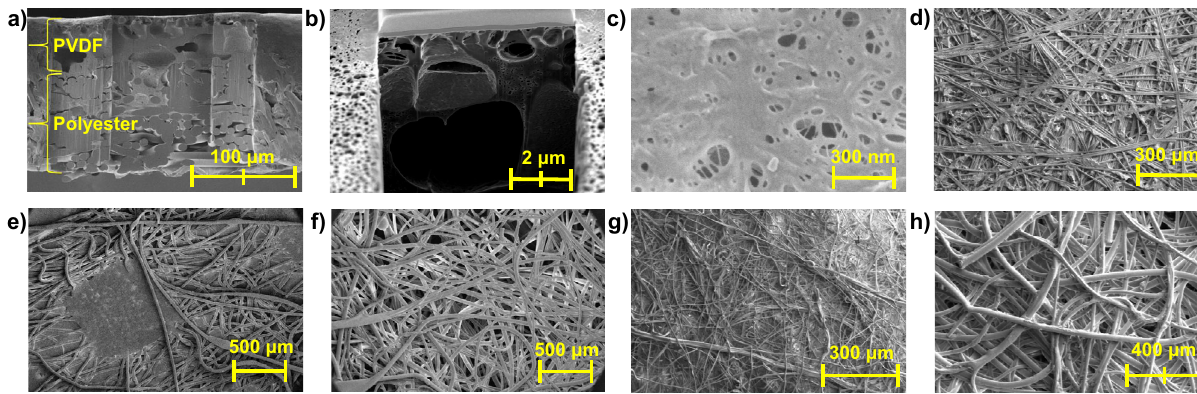
Fig. 1 SEM of PVDF400 commercial membrane and N95 mask. a full thickness cross-section of PVDF400 and b PVDF-only layer cross-section. Surface of c PVDF layer and d polyester support layer. SEM images of N95 layers ( e ) 1, ( f ) 2, ( g ) 3, and ( h ) 4. In mask orientation, layer 1 is exposed to the open environment and layer 4 is exposed to the inside of the mask. Layer 3 is referred to as the “ separating ” layer, as it had the highest fl ow